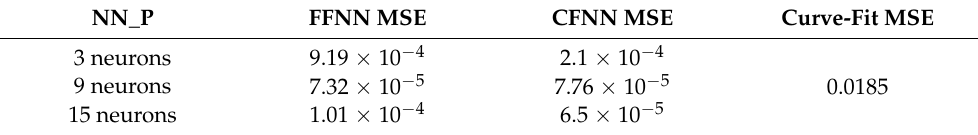
Table 1. Mean square error (MSE) for FFNN, CFNN, and curve fit tool for NN_P for MPP